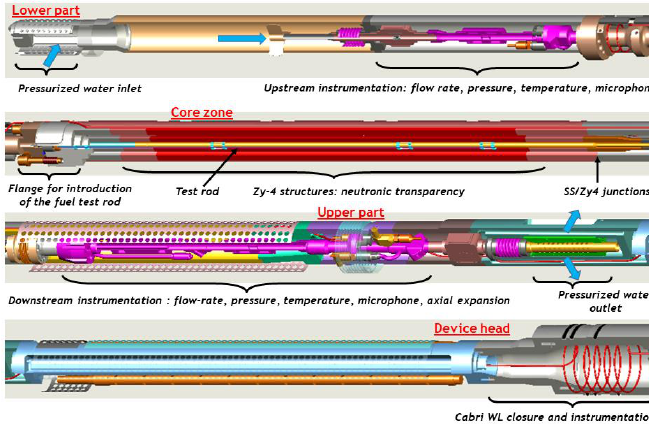
Fig. 1. Test device simplified